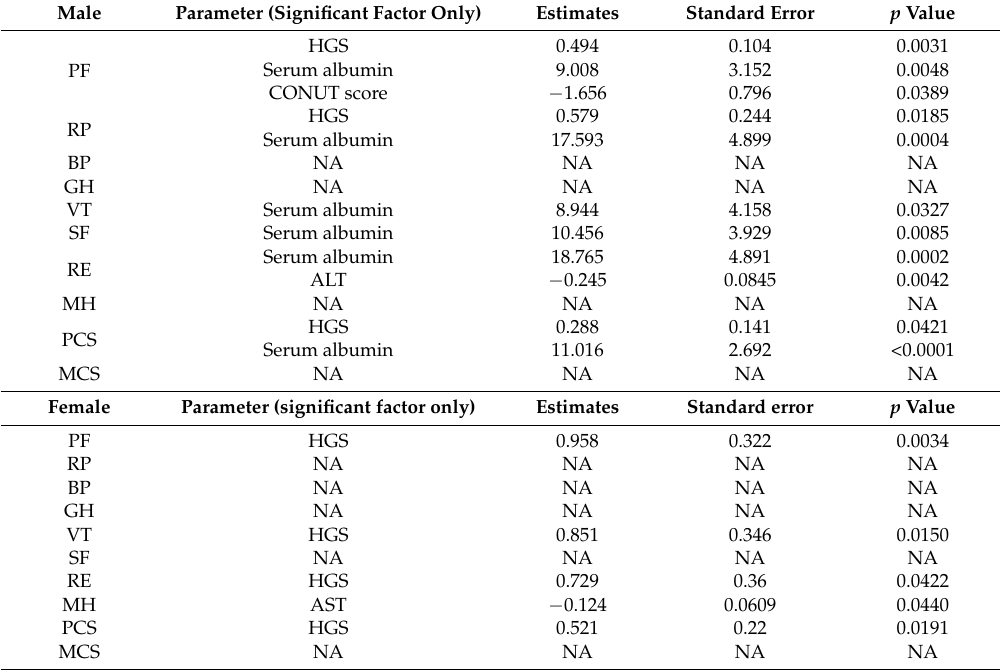
Table 5. Multivariate analyses of factors linked to the SF-36 scores in male and female patients. Male Parameter (Significant Factor Only) Estimates Standard Error p Value